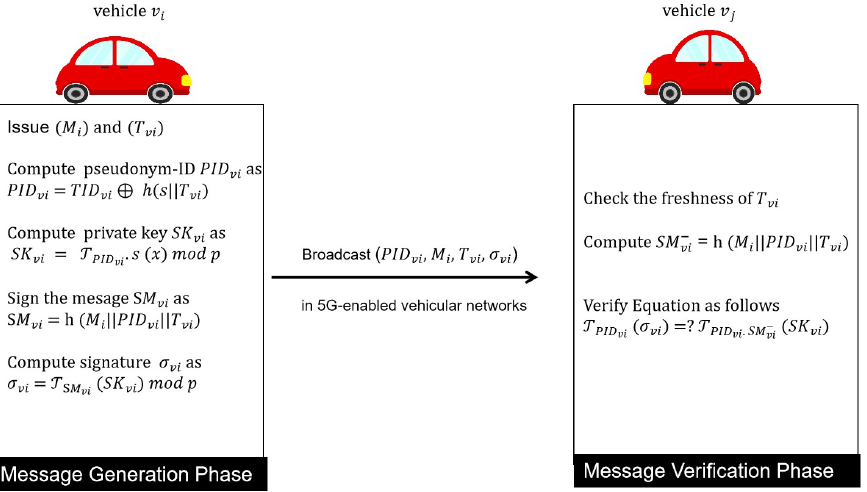
Figure 3. Message Generation and Verification